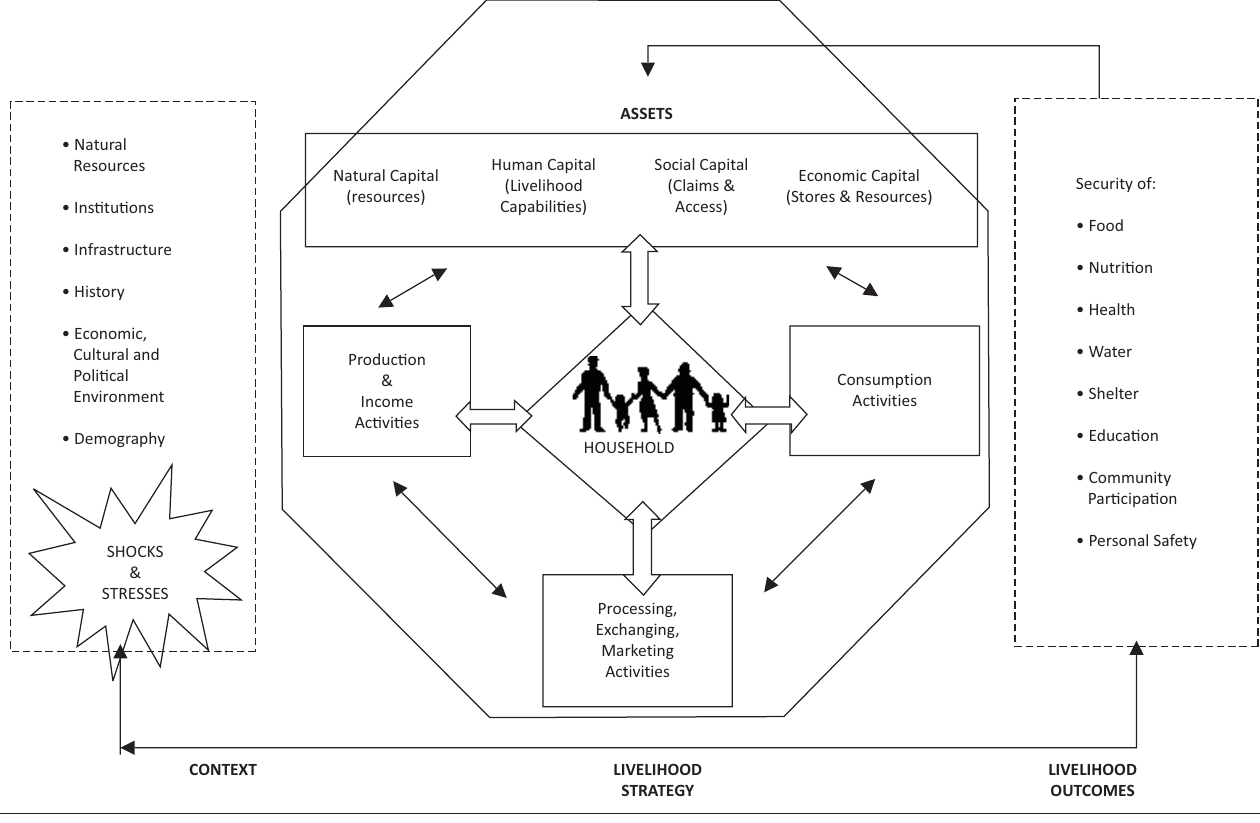
FIGURE 2: The CARE Household Livelihood Security